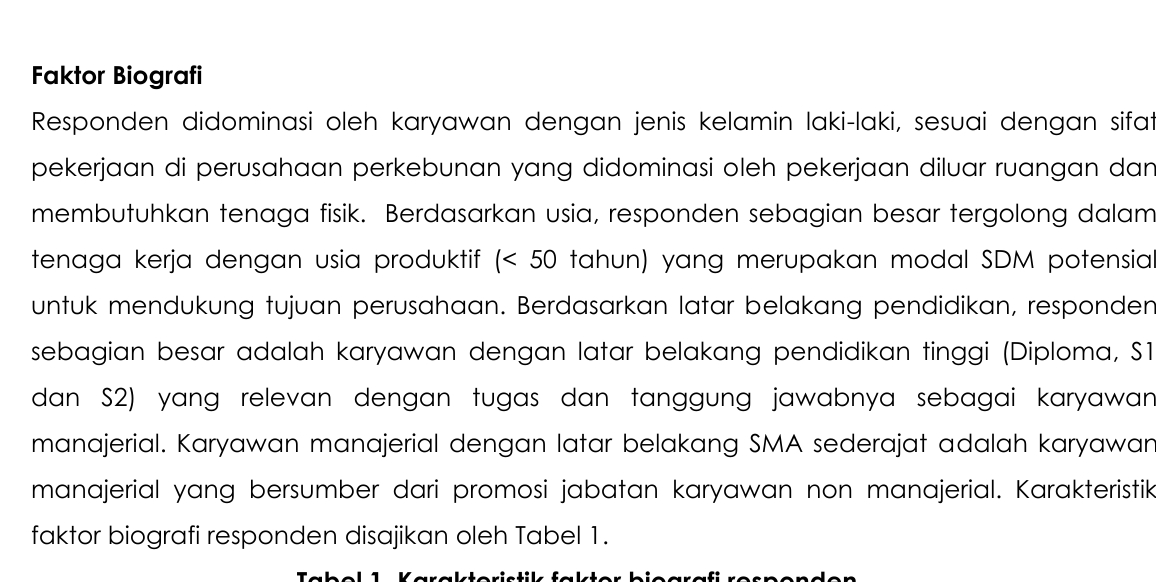
Tabel 1. Karakteristik faktor biografi